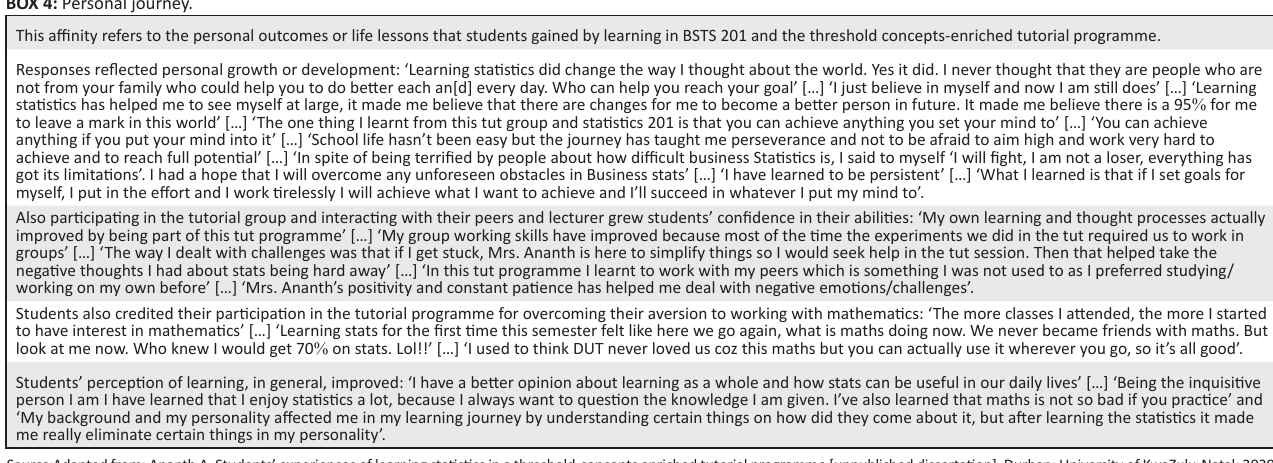
TABLE 1: Affinities in descending order of frequency with Pareto and power analyses. Number Affinity pair Frequency Cumulative Cumulative Cumulative relationship frequency relationships ( % ) frequency ( % )